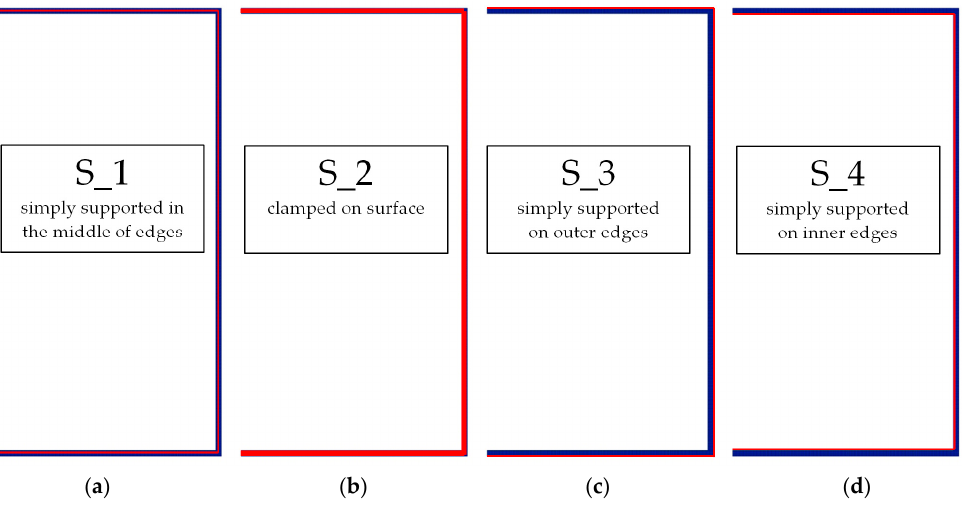
Figure 6. The type of upper and lower supports of column for ( a ) S_1 ( b ) S_2 ( c ) S_3 and ( d ) S_4. Table 1. The critical loads with di ff erent boundary